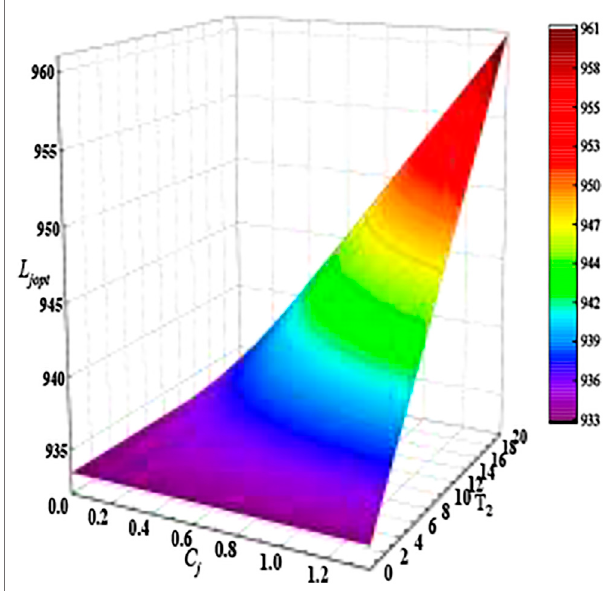
FIGURE 7 | Building materials business ’ s optimal pro fi t and carbon allowance, internal carbon